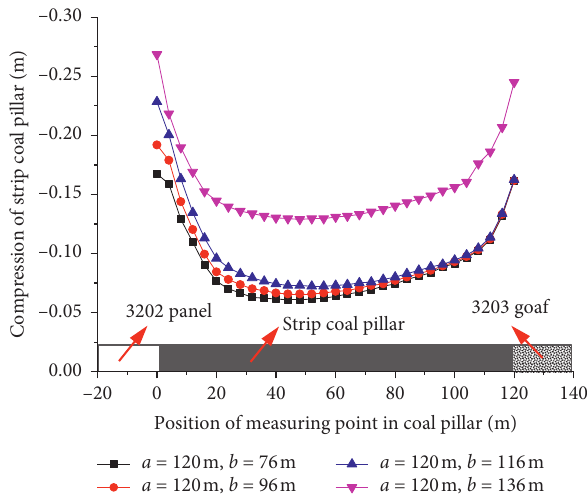
Figure 7: Compression of strip coal pillar under different coal pillar widths.